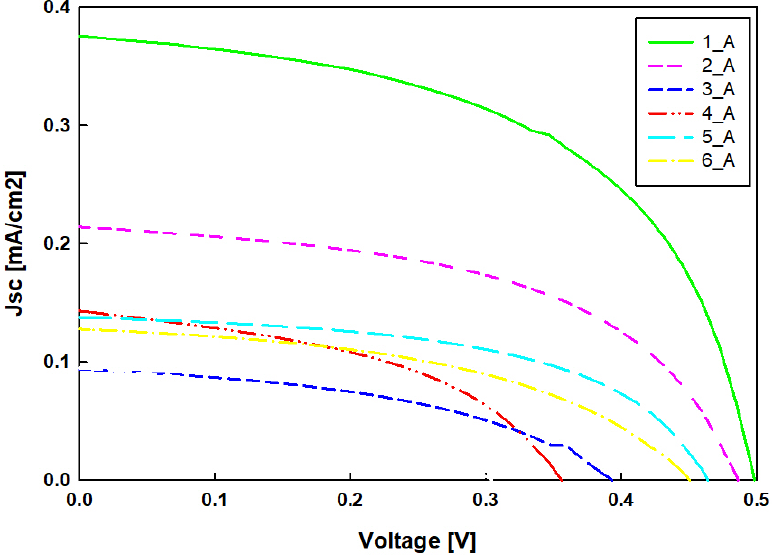
Figure 9. The J–V curves of DSSCs based on the quinoidal bases A under 100 mW · cm − 2 simulated AM 1.5 G illumination.